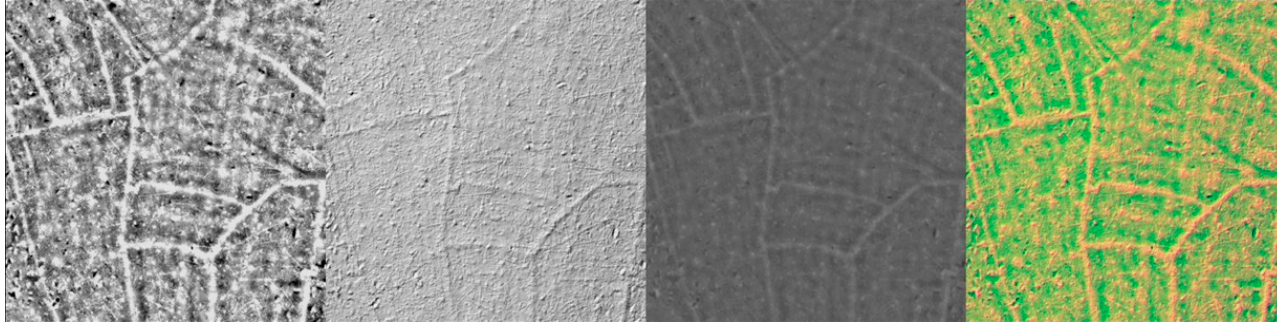
Figure 2. Examples of DTM visualization (250 × 250 m): SLRM, analytical hillshading, LD, modality fusion.